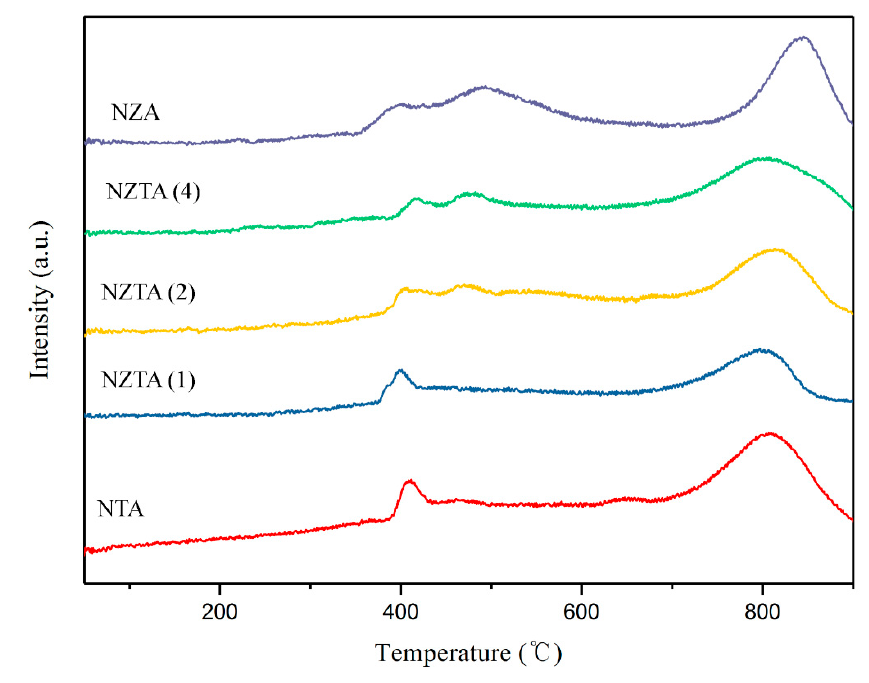
Figure 2. H 2 -TPR profiles of the prepared catalysts.